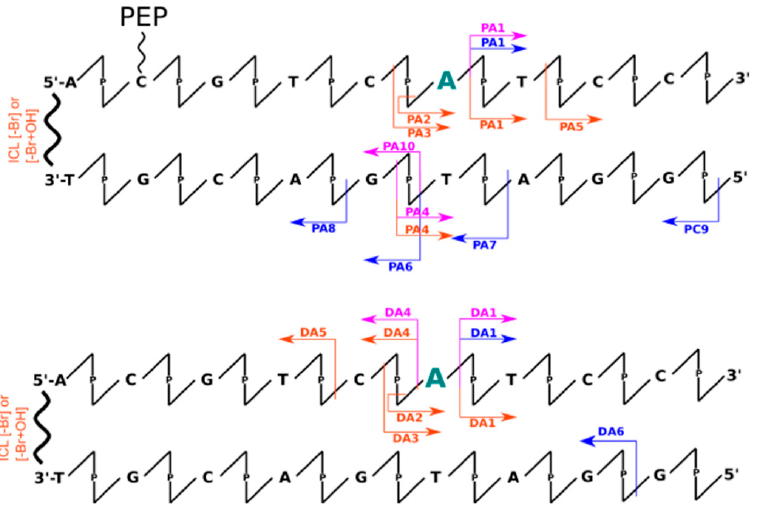
Figure 1. Schematic representation of all identified oligonucleotides’ fragments by means of LC-MS for BrdA labeled systems (upper with peptide conjugate, lower without peptide conjugation). The scheme represents only part of the dsDNA structure. The arrows represent the respective fragments identified for X-ray radiation experiments (blue), UV irradiation by 320 nm photons (pink), and 280 nm photons (orange). Modified nucleobase was pointed in green. Below the arrows the names of identified fragments are listed starting with “P” stands for system with peptide conjugation, starting with “D” without peptide conjugation. Additionally, the interstrands cross-links (ICL) were observed. For possible mechanisms, please see Figures S7–S11.